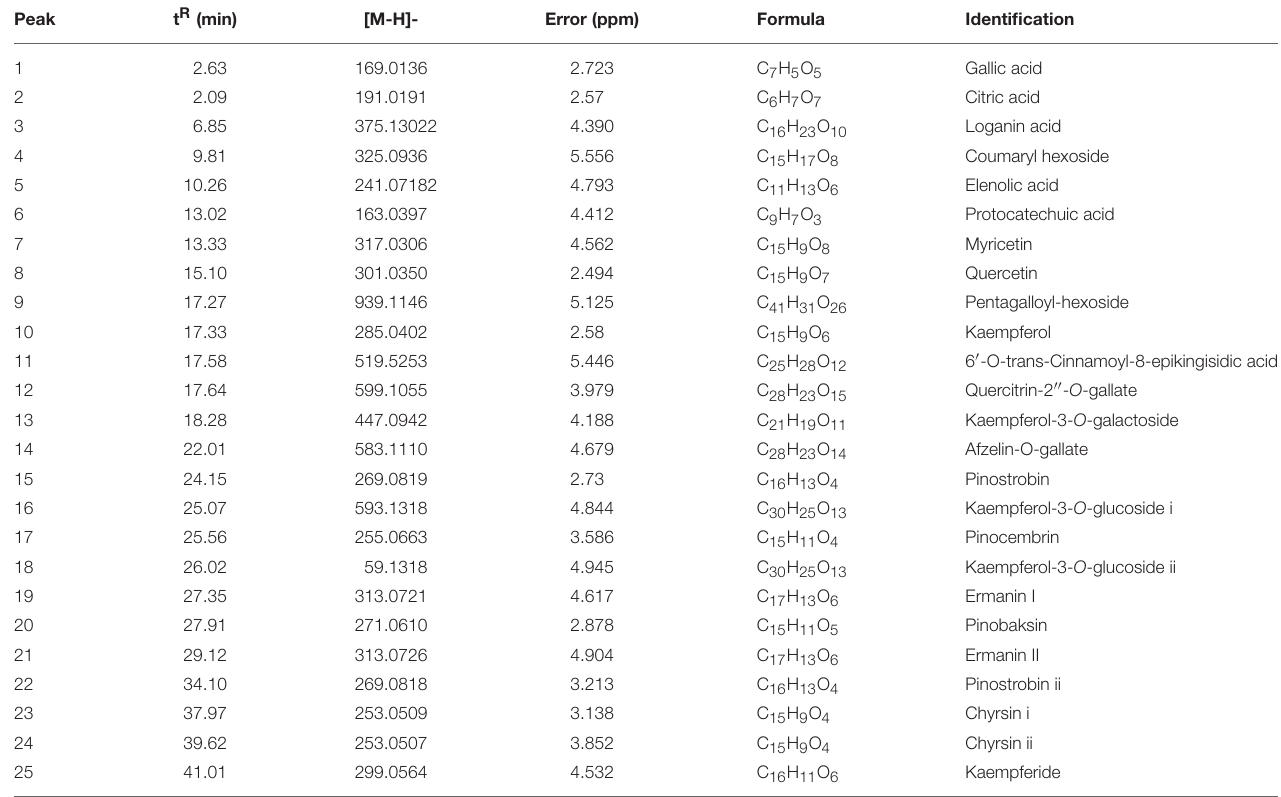
TABLE 9 | Phenolic compounds identified in AQMC by UHPLC-ESI-MS/MS. Peak Formula